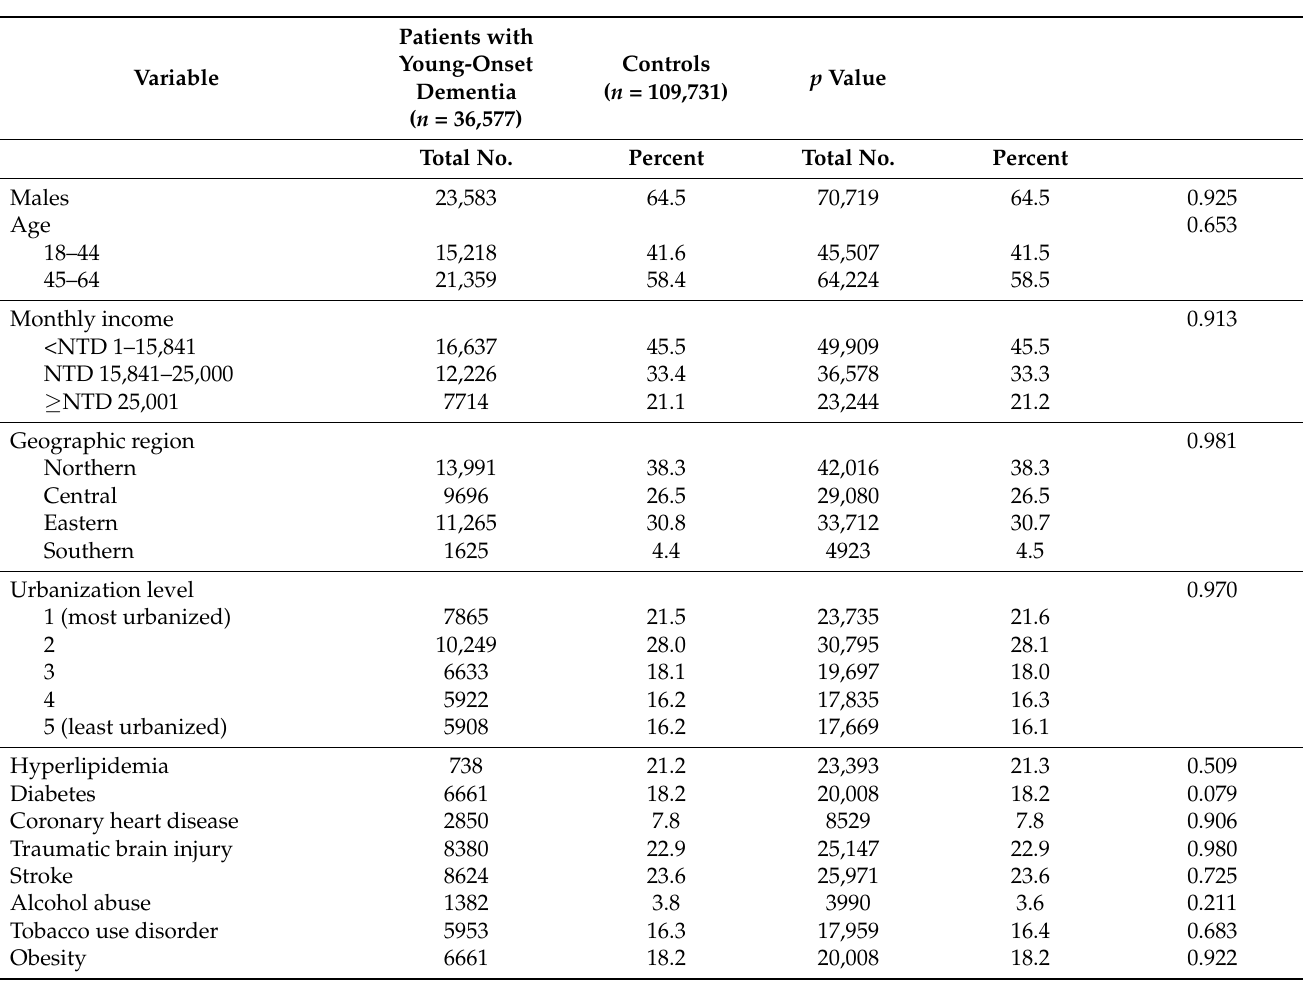
Table 1. Demographic characteristics of patients with young-onset dementia and control patients in Taiwan ( n = 146,308).